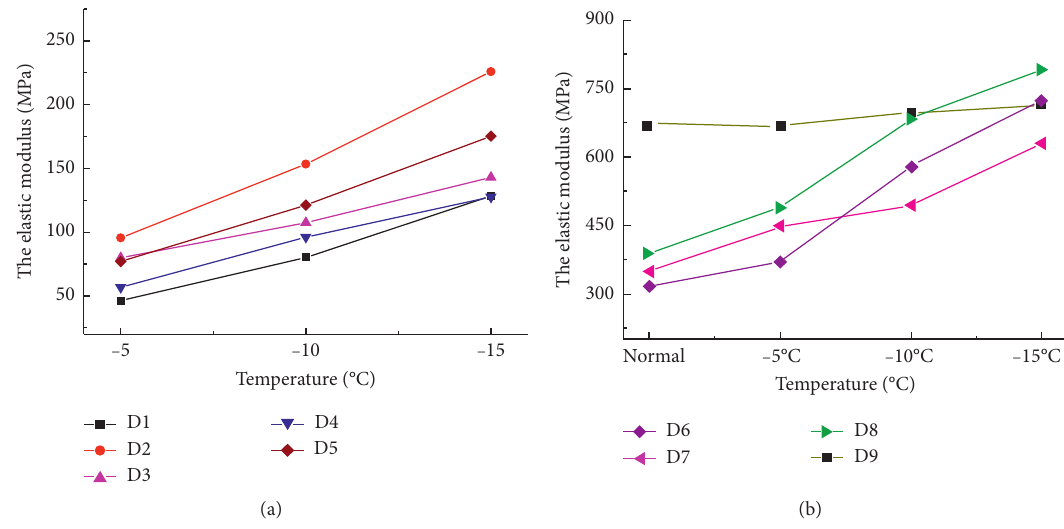
Figure 2: Elastic moduli of different rock and soil strata versus temperature. (a) Topsoil strata. (b) Rock